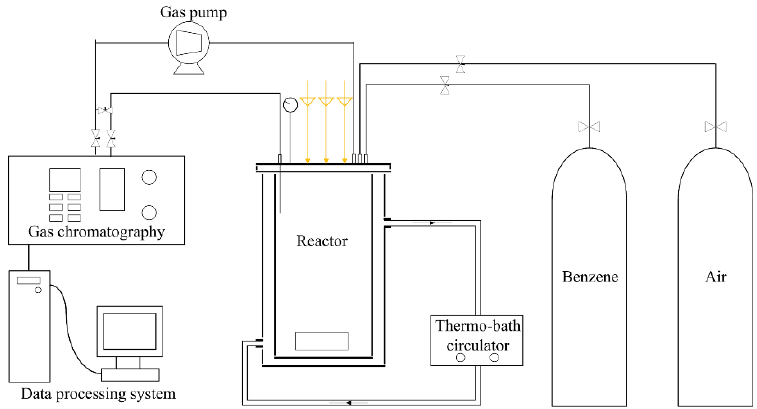
Figure 7. Schematic illustration of the photocatalytic reaction.